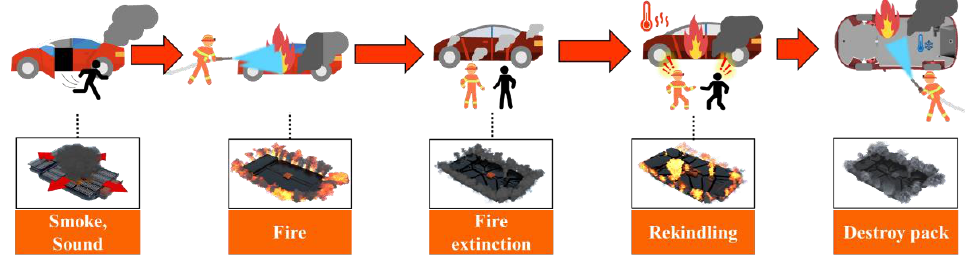
Figure 5. The main process of an EV fire accident.